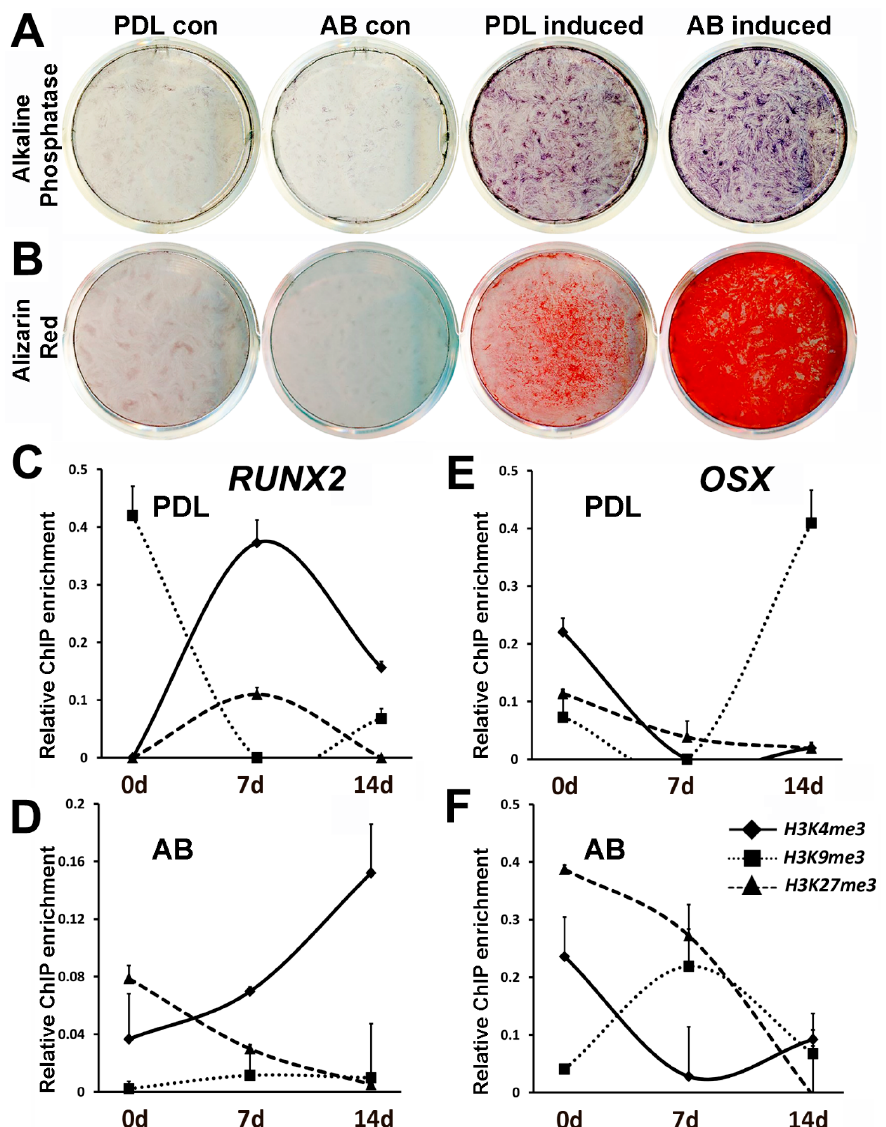
Figure 3. Comparison of PDL and AB progenitor mineralization potential and histone modification dynamics at RUNX2 and OSX promoters upon osteoinduction. ( A ) Alkaline phosphatase activity in PDL and AB progenitors subjected to mineralizing conditions for 7 days. ( B ) Calcium deposition analyzed by Alizarin Red staining in PDL and AB cells after 21 days of induction. ( C–F ) Histone dynamics for RUNX2 and OSX promoters in PDL and AB progenitors under mineralizing conditions after 7 and 14 days. Changes in histone H3K4me3, H3K9me3 and H3K27me3 enrichment levels are depicted as scatter plots. ChIP analysis for RUNX2 promoter in ( C ) PDL cells and in ( D ) AB cells. ChIP analysis for OSX promoter in ( E ) PDL cells and in ( F ) AB cells. ChIP data are representative of independent experiments with similar results (n = 4–5). Enrichment values are graphed as mean ±